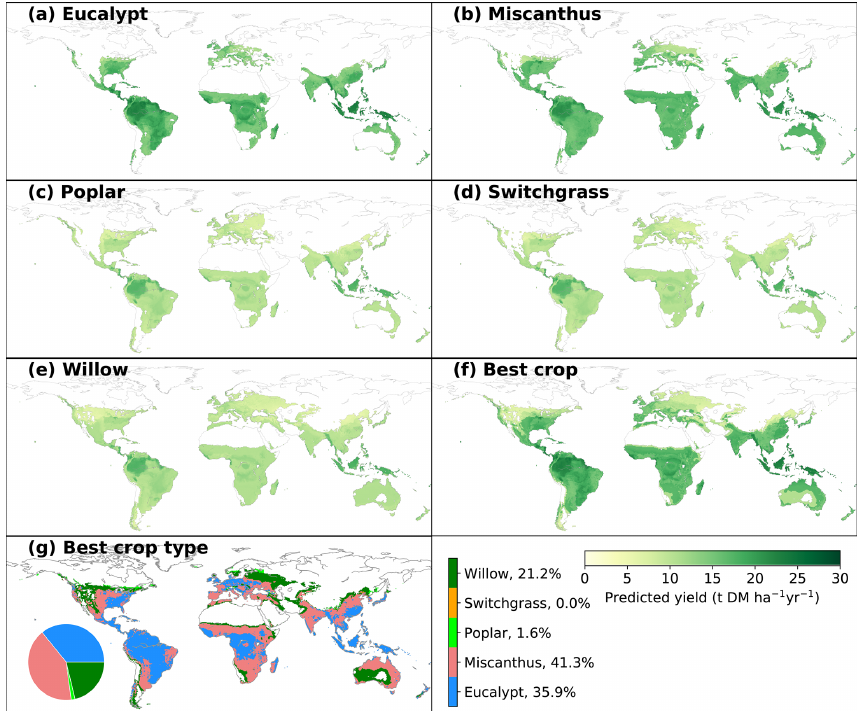
Figure 3. Spatial distribution of predicted yields for different bioenergy crops (a–f) and best crop type in each grid cell that is adequate for growth (g) . The inset pie plot in (g) shows the fractions of grid cells occupied by each bioenergy crop type. The white areas indicate regions where no prediction was derived due to inadequate conditions defined by minimum temperature and precipitation (see Sect.